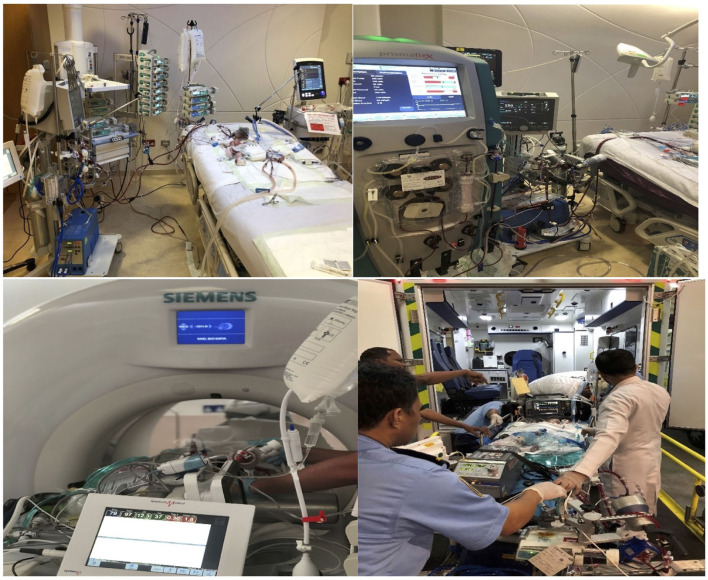
First ECMO patient.